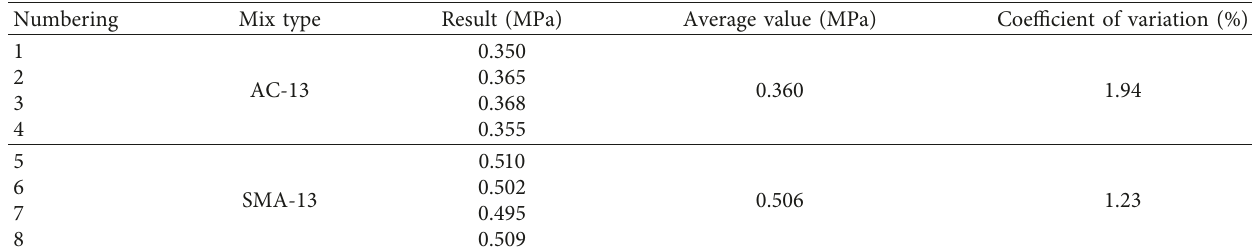
Figure 11: Model of loading. Table 10: Results of torsion shear numerical simulation